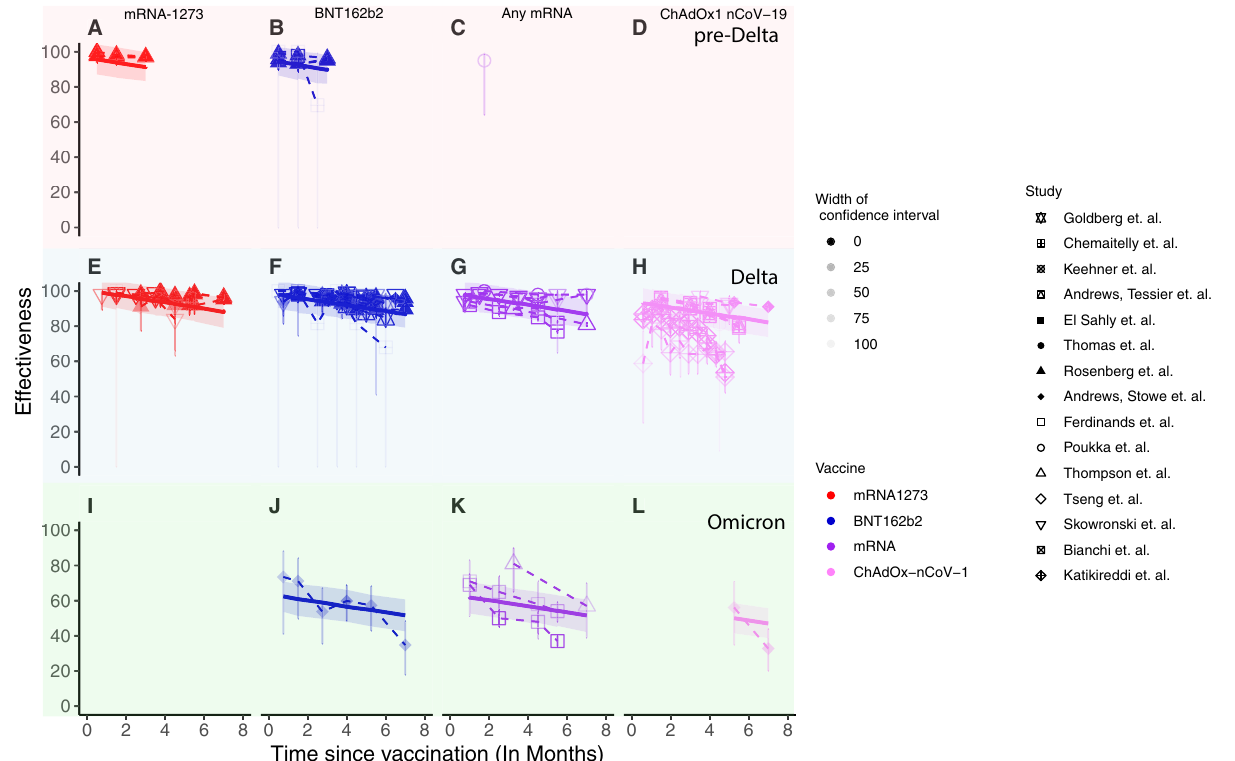
the data as determined by the width of the con fi dence interval. Predicted vaccine effectiveness using a linear mixed effects regression model (solid lines) and 95% con fi dence intervals (shaded area) are overlaid. The fi gure shows effectiveness following mRNA-1273 (red), BNT162b2 (blue), any mRNA (purple) and ChAdOx- nCov-1 (pink) vaccination.